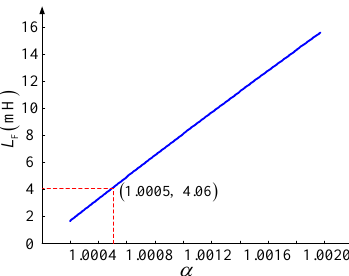
Figure 11. The relationship between L F and α .